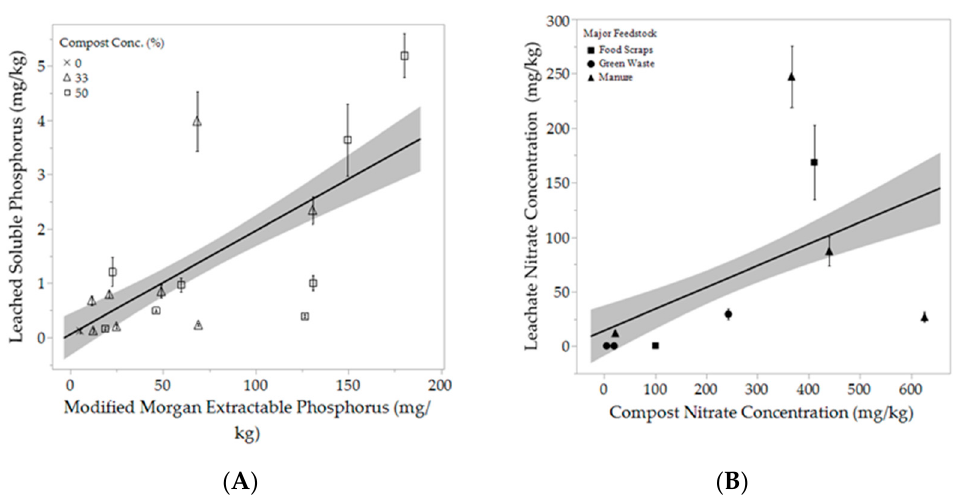
Figure 6. ( A ) displays the relationship between extractable (available) phosphorus content of the amended and unamended soil with concentration of soluble reactive phosphorus found in leachate. The black line represents the line of best fit; R 2 = 0.417. The 100% compost treatment is excluded for ease of interpretation. ( B ) displays the relationship between nitrate concentration in the composts alone (100% compost). The manure-based compost in the lower left-hand corner is the WCE poultry manure compost which leached very little nitrate because the nitrogen in the compost was primarily in the form of ammonium. The black line represents the line of best fit; R 2 = 0.145. In both graphs the shaded area denotes a 95% confidence interval. Each point represents the mean, error bars denote standard error (n = 6).